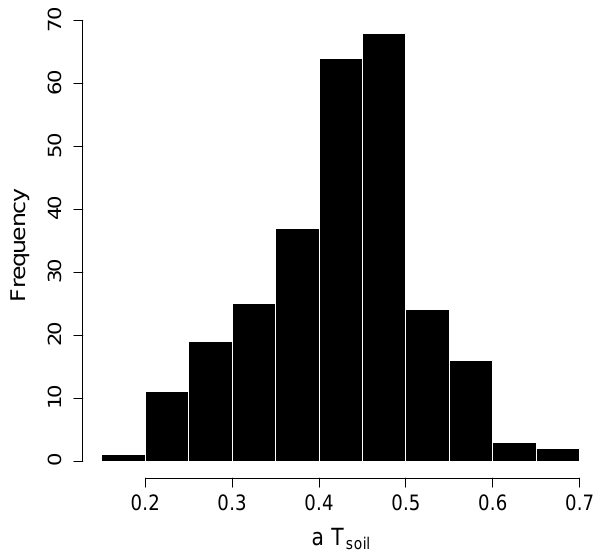
Fig. 5. Median weights of the optimised temperature for the soil part across site and year.